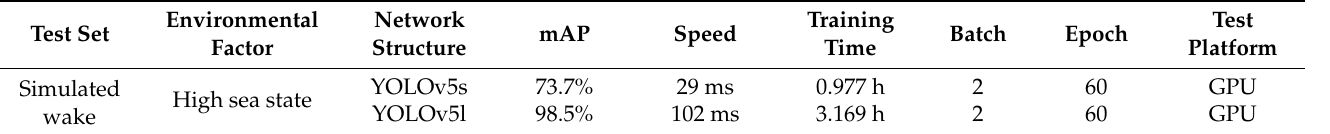
Table 4. Training results of simulated wakes based on different network structures of